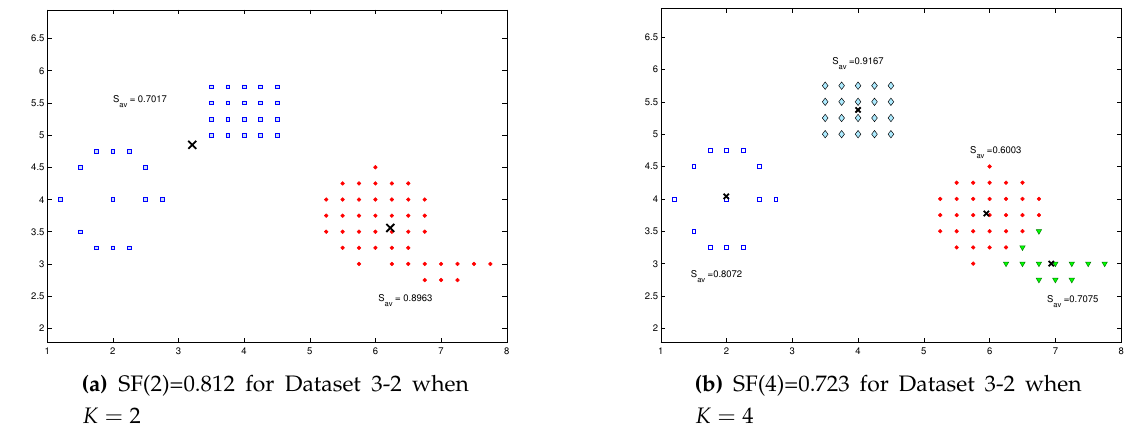
Figure 3. The cluster silhouettes for Dataset 3-2 to determine clusters must be split or merge for Dataset